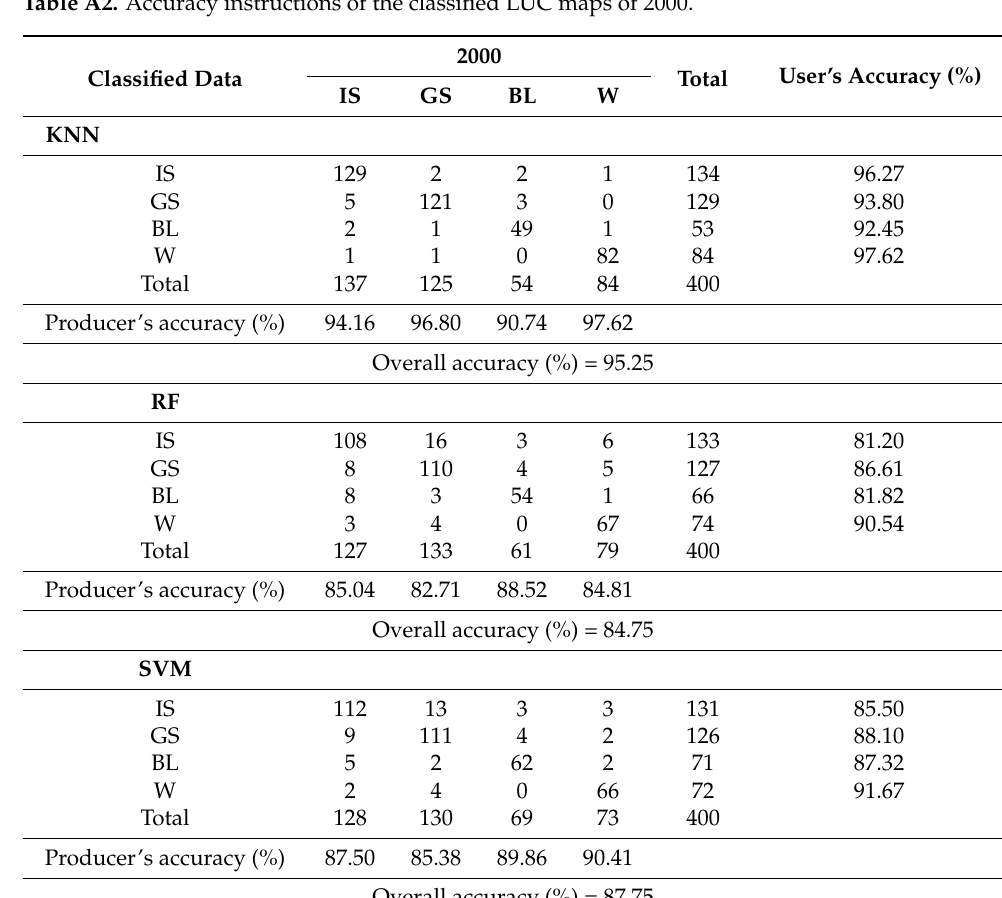
Table A2. Accuracy instructions of the classified LUC maps of